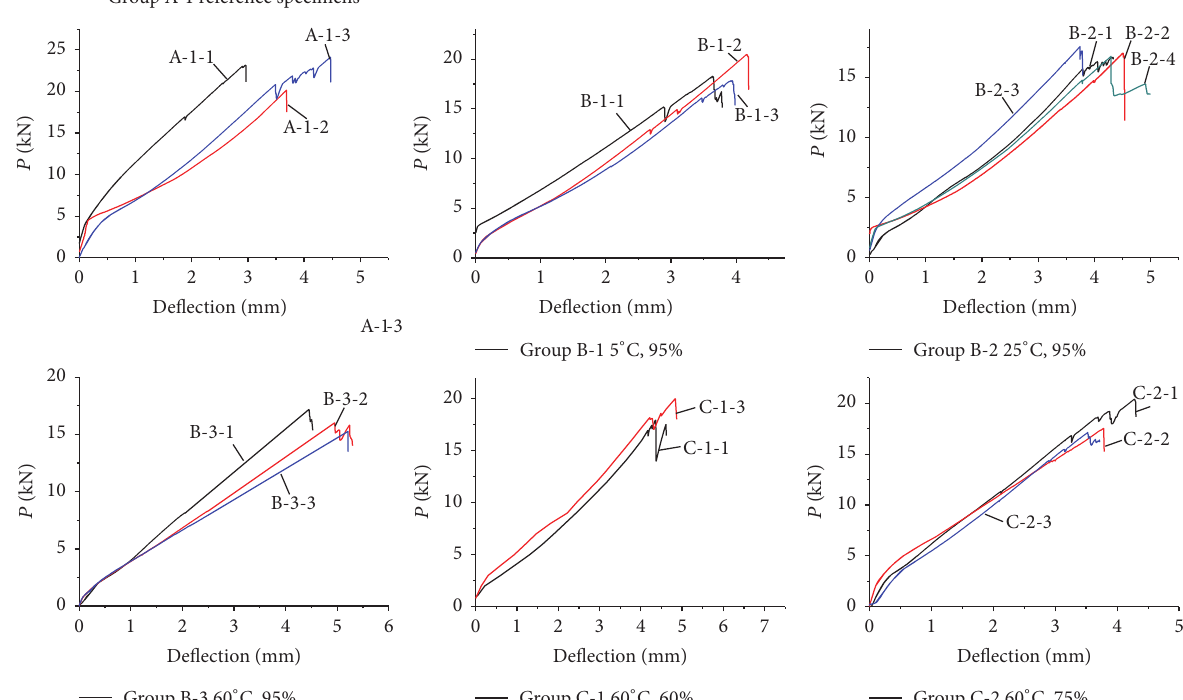
Figure 10: Load-deflection curves of all the